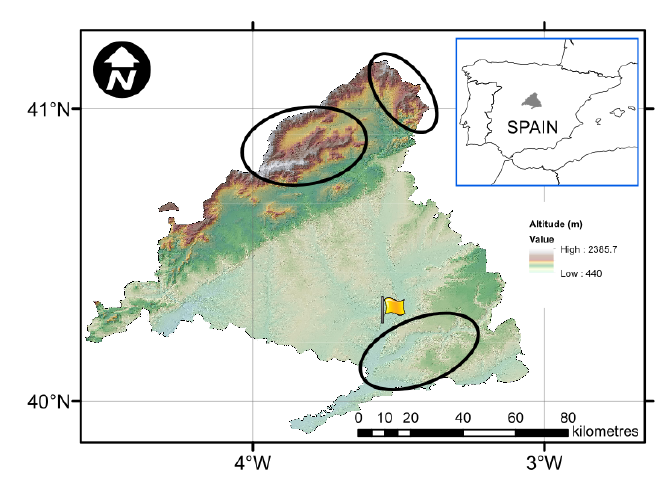
Figure 1. Collection sites of the old apple cultivars from central Spain. The two upper ellipses indicate accessions from Sierra Norte de Madrid and the lower one, from the Tagus River basin. The yellow flag indicates the location of the IMIDRA collection. MDT25 2015 and BDLJE 2018, CC-BY 4.0